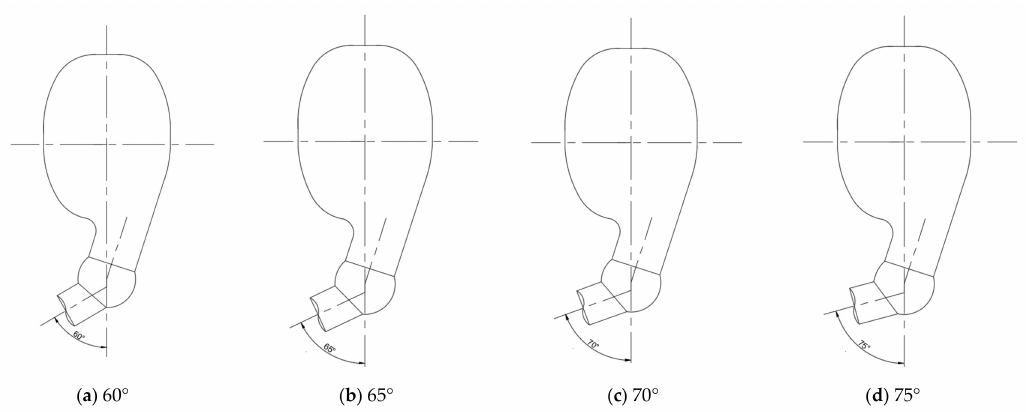
Figure 14. Di ff erent schemes of PCC nozzle